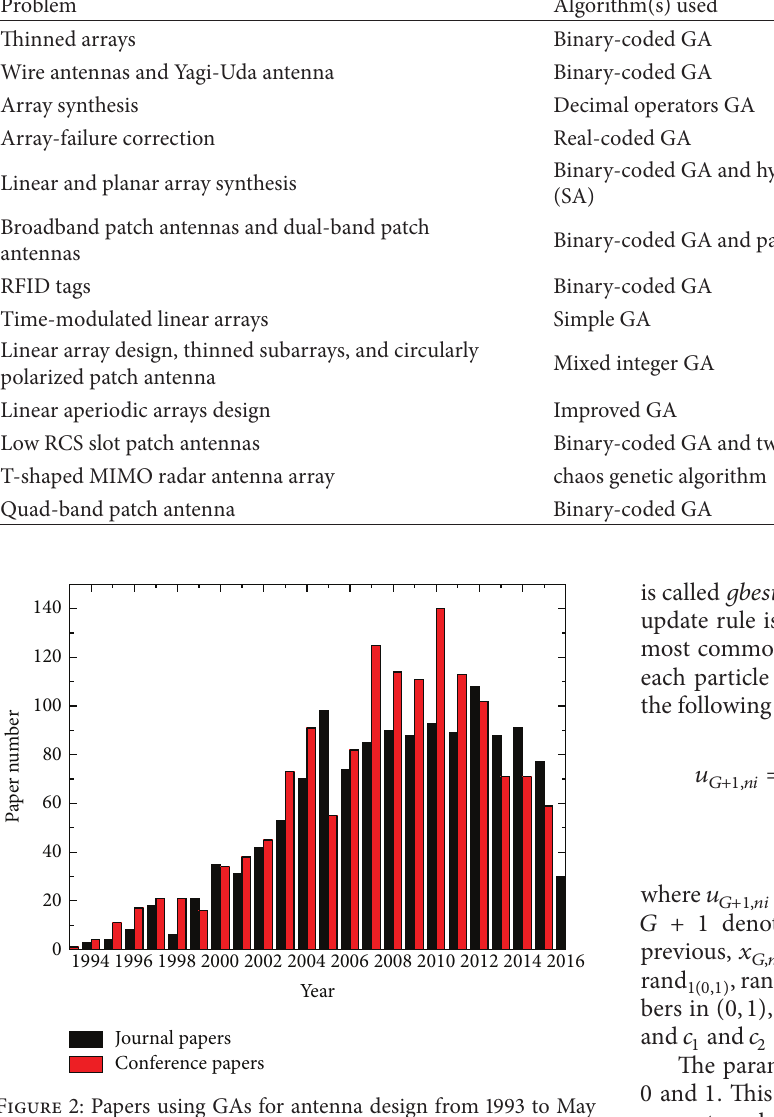
Figure 2: Papers using GAs for antenna design from 1993 to May